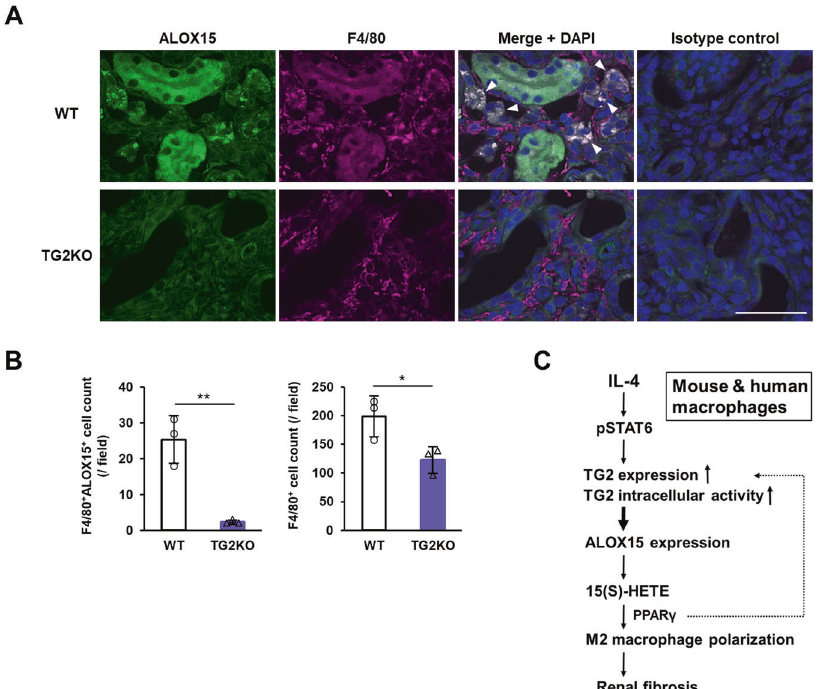
Fig. 8 Evaluation of ALOX15 distribution in fi brotic kidney and its association with renal fi brosis. Kidney section on day 12 after UUO surgery were fi xed in 4% paraformaldehyde and immunostained using anti-F4/80 plus Alexa Fluor 594 anti-rat antibodies and anti-ALOX15 plus Alexa Fluor 488 anti-rabbit antibodies ( A ). As an isotype control, each primary antibody was replaced with the same amount of rat and rabbit NI-IgG. The nuclei were counterstained with DAPI. Arrowheads indicate the similar distributions between ALOX15 and F4/80. Scale bar = 50 μ m. Representative results in at least three independent samples were shown. The numbers of F4/80 + ALOX15 + cells and F4/80 + cells in fi ltrating kidney of WT and TG2KO mice after UUO were presented ( B ). Data are presented as the mean ± SD ( n = 3) (** P < 0.01, * P < 0.05, Student ’ s t test). Schematic showing the molecular mechanism by which TG2 causes M2 polarization via ALOX15 expression and its metabolism in mouse and human macrophages, leading to renal fi brosis ( C